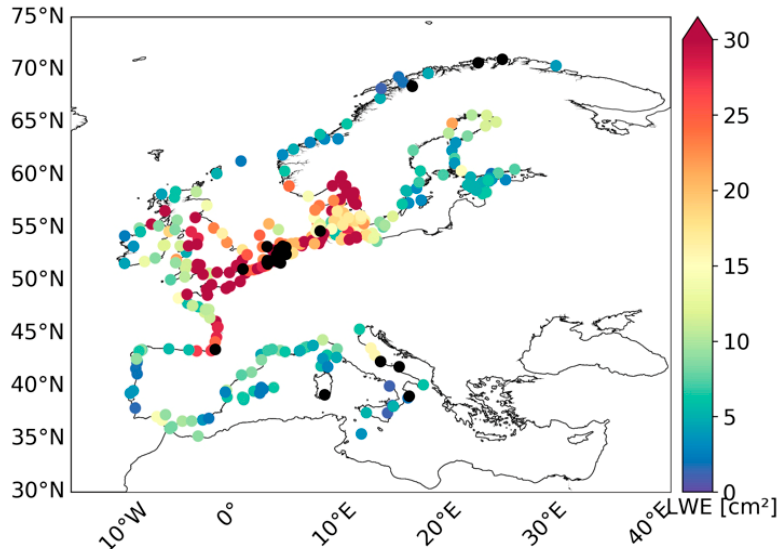
Figure 4. Spatial distribution of the variance (cm 2 ) of Long Wavelength Error (LWE) correction applied on SLA measurements (without filtering) from the Sentinel-3A dataset along the European coasts. Black dots denote the location of the tide gauge sites rejected from the computation according with the selection criteria described in the text.